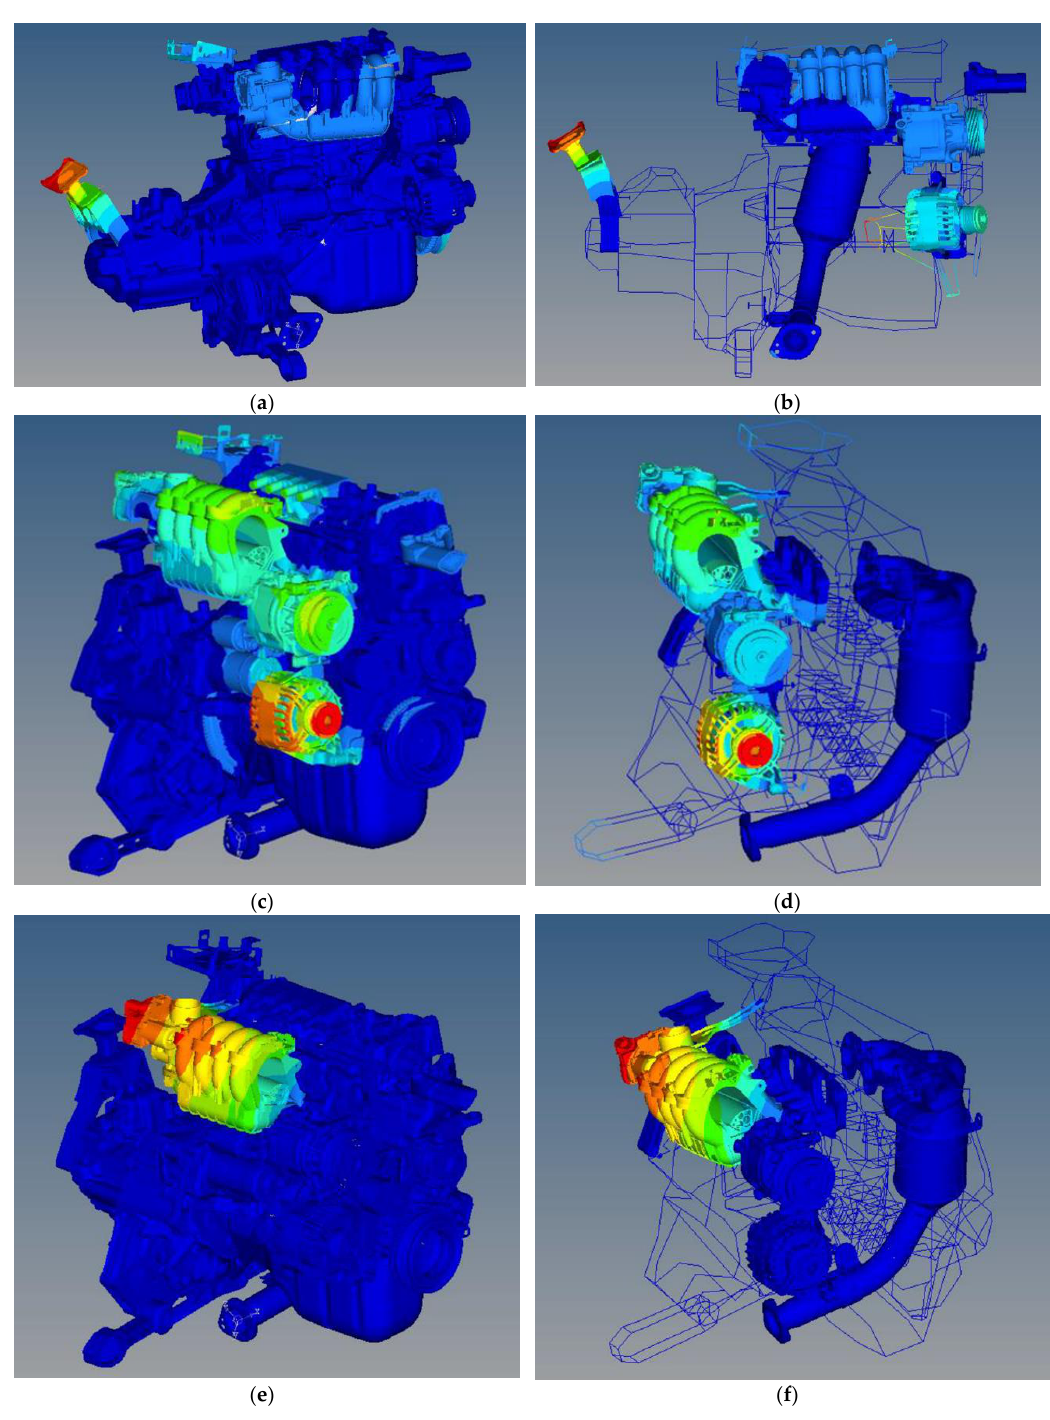
Figure 16. Comparisons of the modal shapes for ( a , c , e ) the full FEM and ( b , d , f ) the reduced FEM model for: ( a , b ) gear mount, ( c , d ) alternator, ( e , f ) intake manifold.